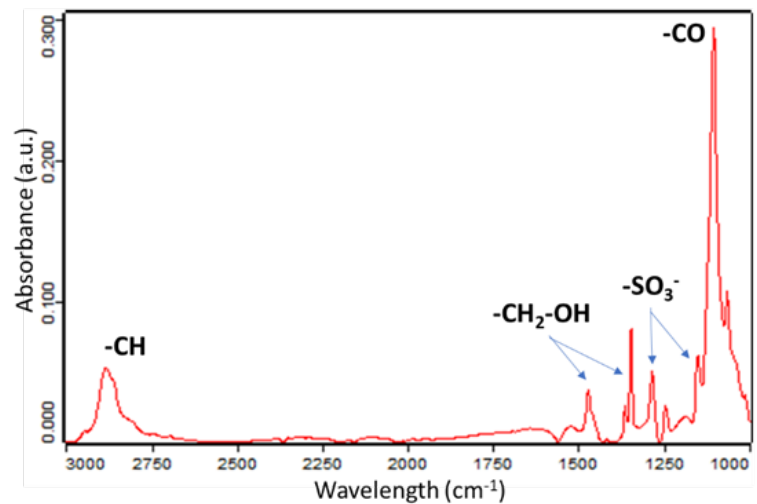
Figure 9. FTIR analysis of the PEO/PEDOT:PSS NFs.